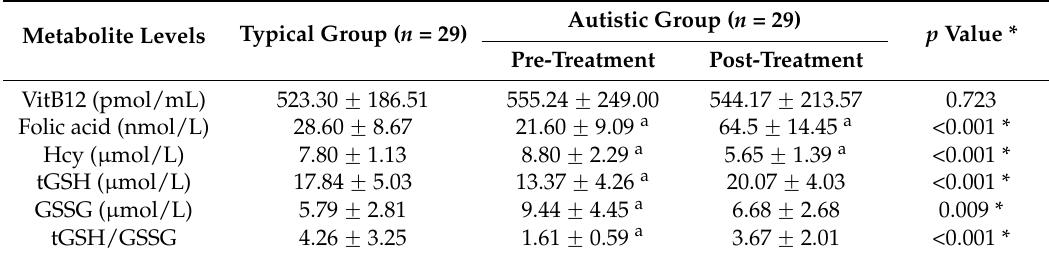
Table 3. Mean plasma metabolite levels (mean ˘ SD) in age-matched control children and autistic children before and after the three-month folic acid treatment.